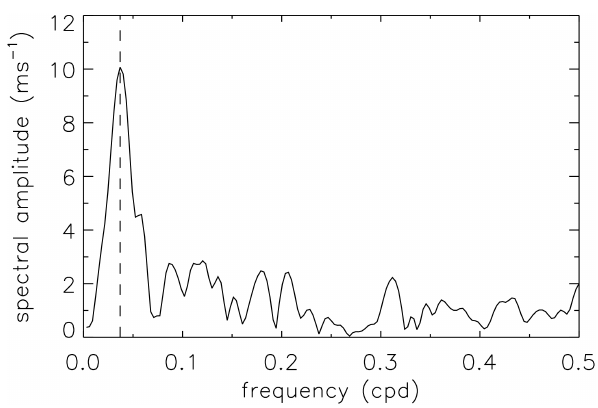
Figure 11. Lomb–Scargle spectrum of zonal wind disturbance at 31km from radiosonde observations over Cold Bay. The dotted ver- tical line corresponds to a period of 27 days.